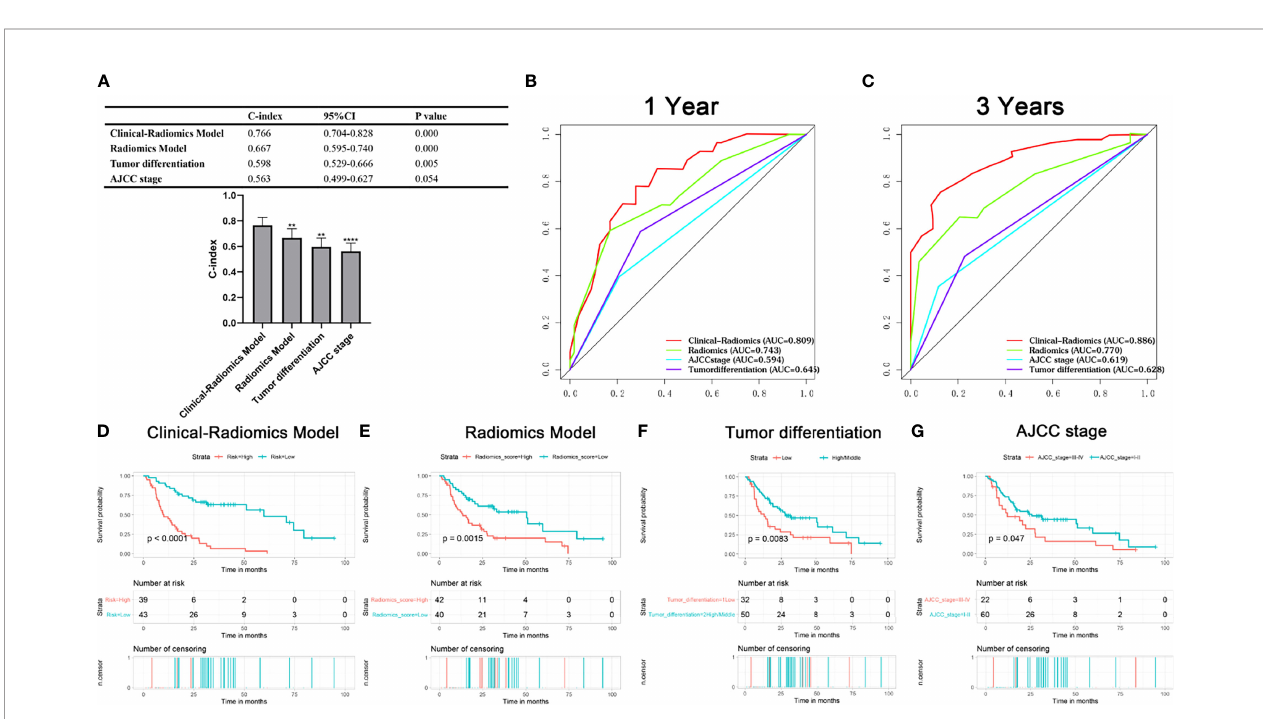
FIGURE 6 | Establishment of ICC patients clinical radiomics model. (A) ICC survival nomogram (B) AUC of OS at 1, 2, and 3 years; (C) DCA of the model. (D – F) Calibration curve for predicting 1-, 2-, 3 -years survival.